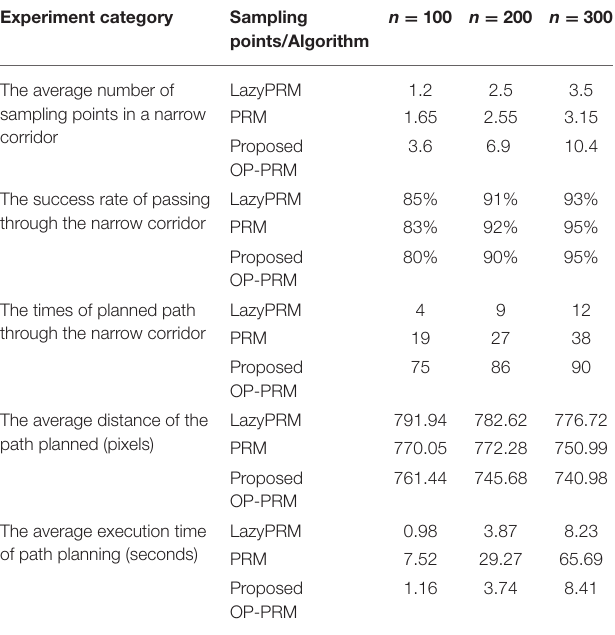
TABLE 2 | Performance evaluation of the path planning algorithms with 100 experiments. Experiment